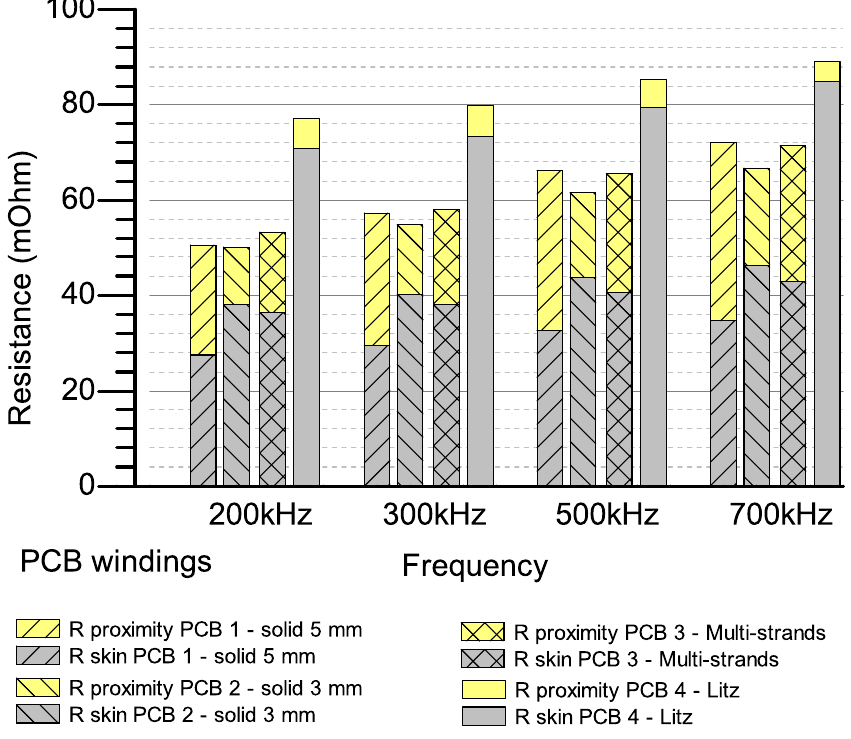
Figure 12. Calculated skin and proximity resistances of 3-turn